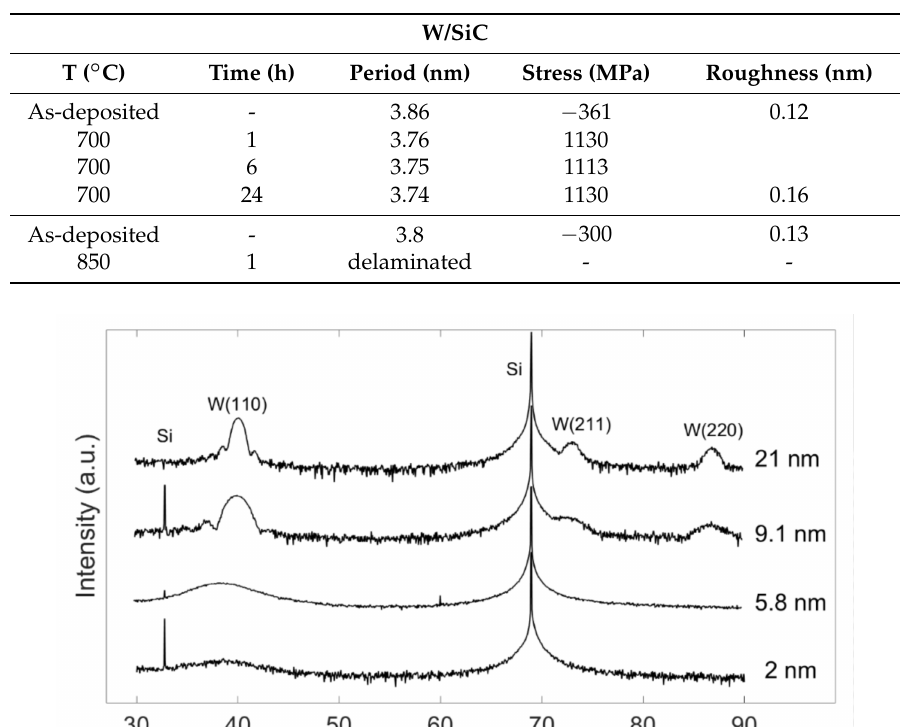
Table 4. W/SiC short multilayer period, stress and surface roughness as a function of annealing temperature. Data following as-deposited sample originate from the same sample.